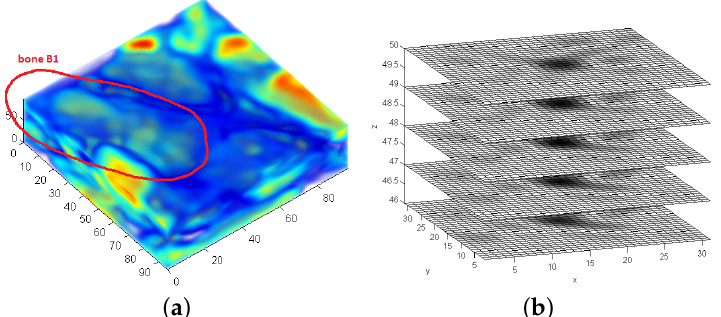
Figure 8. Example of a registration, which is still successful in the outer region of the search frame. ( a ) Example of subframe where the object of interest lies in the outer region. ( b ) Corresponding registration